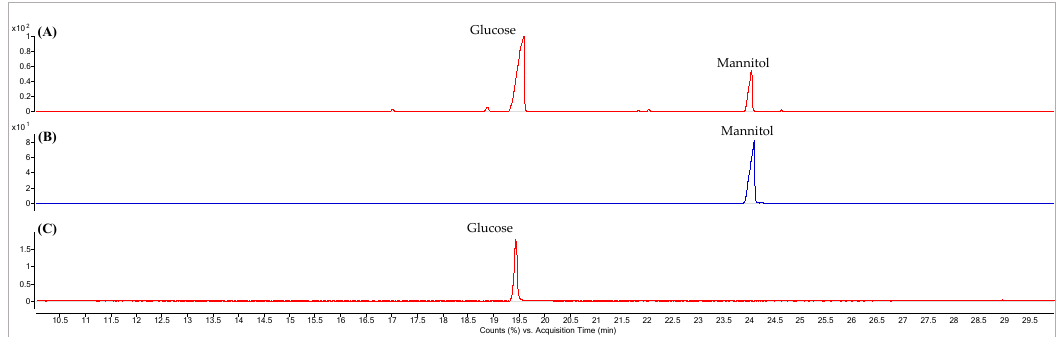
Figure 5. GC ‐ MS chromatograms of acetylated methyl glycosides from RSLDE OUT ( A ); acetylated mannitol ( B ); acetylated methyl glycoside of glucose ( C ).